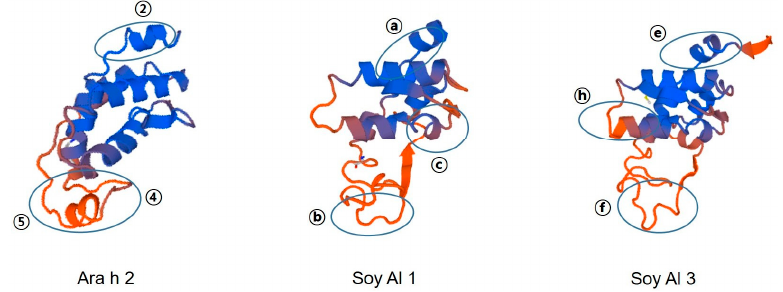
Figure 4. Predicted 3D structure and major epitope of Ara h 2, Soy Al 1, and Soy Al 3. Blue and red colors represent the helix and loop structure, respectively. Identified epitopes are indicated with ovals.